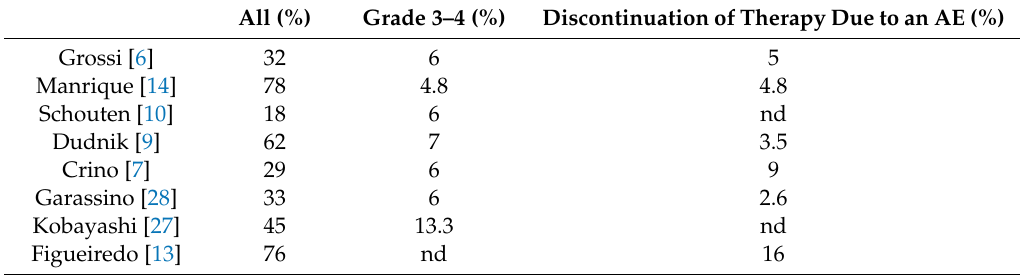
Table 4. Incidence of adverse events (AEs) in patients treated with nivolumab—real-world data. All (%) Grade 3–4 (%) Discontinuation of Therapy Due to an AE (%) Grossi [6] 32 6 5 Manrique [14] 78 4.8 4.8 Schouten [10] 18 6 nd Dudnik [9] 62 7 3.5 Crino [7] 29 9 Garassino [28] 33 6 2.6 Kobayashi [27] 45 13.3 nd Figueiredo [13] 76 nd 16 nd—no